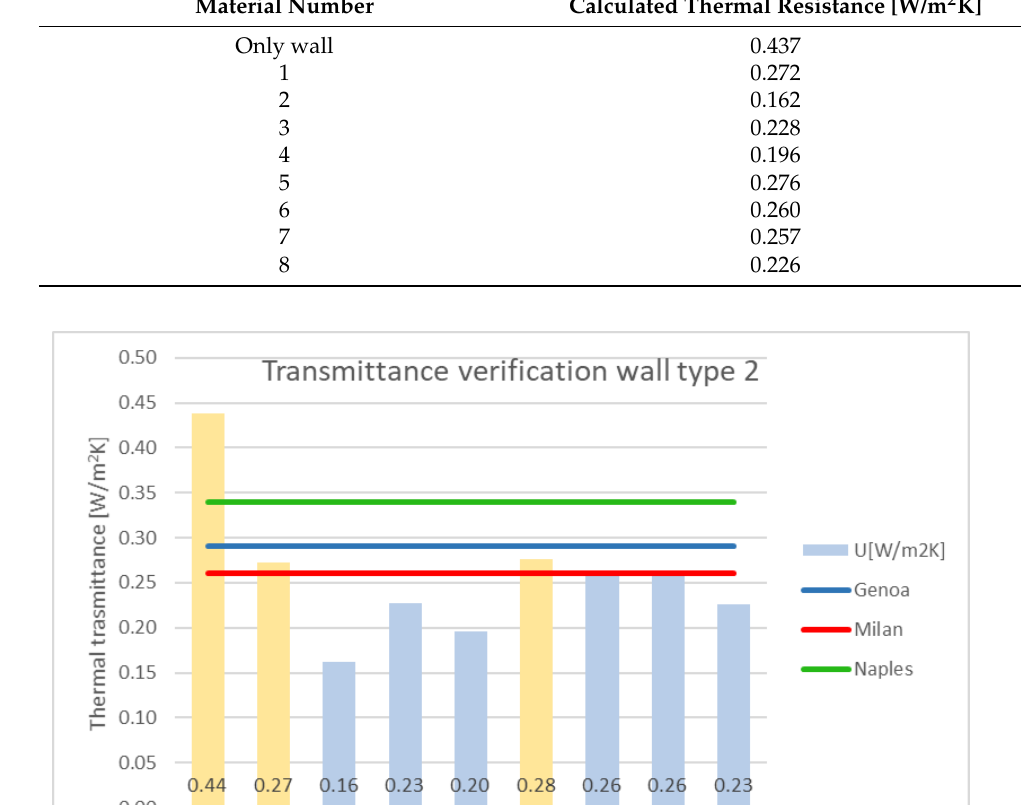
Figure A5. Wall type 3.1: stratigraphy with thicknesses and conductivities for the different layers. The numbers start from the outside.